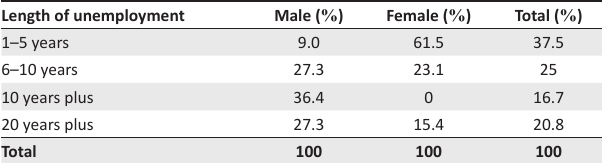
TABLE 1: Length of unemployment by sex ( N = 24 Females 13 and males 11). Length of unemployment